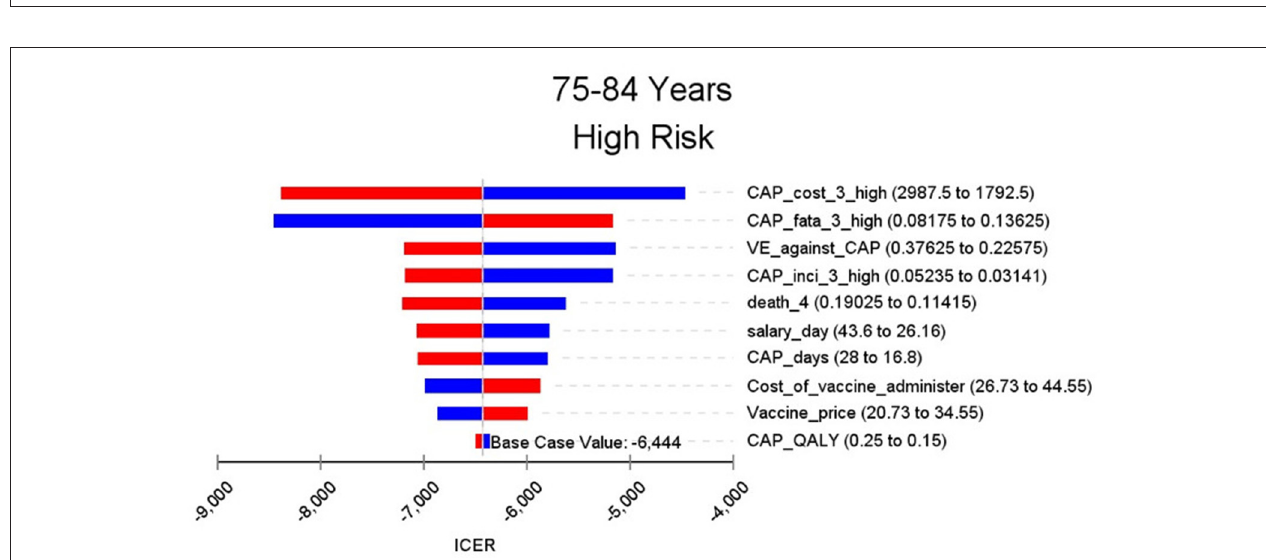
FIGURE 7 | Sensitivity analysis in group 75–84 years and high